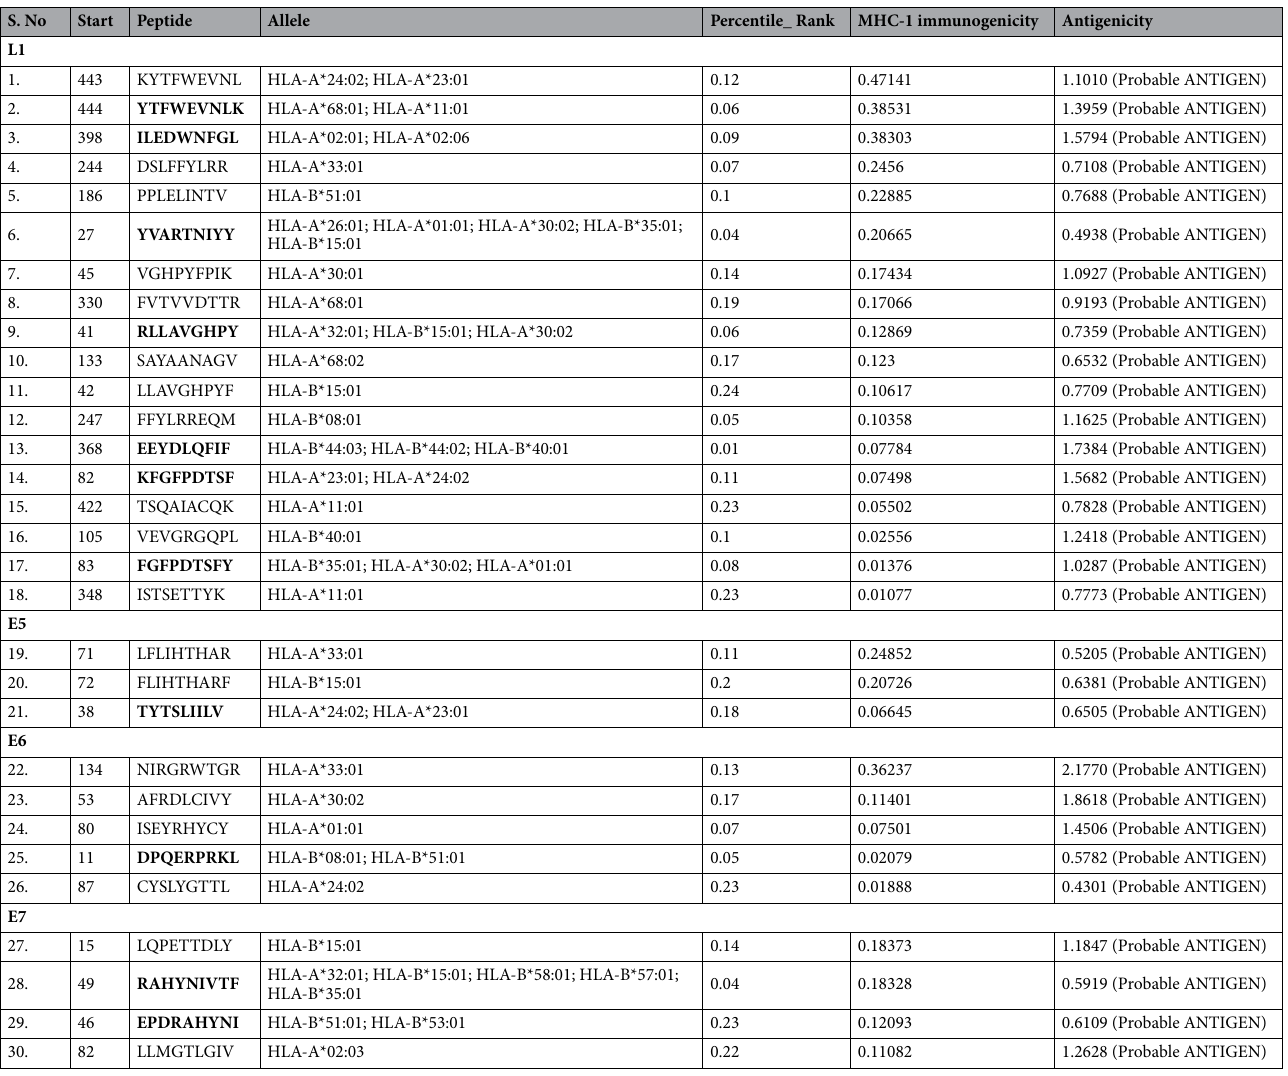
Table 1. MHC-I epitopes of L1, E5, E6, & E7 proteins of HPV 16. Bold text represents the peptides used in vaccine